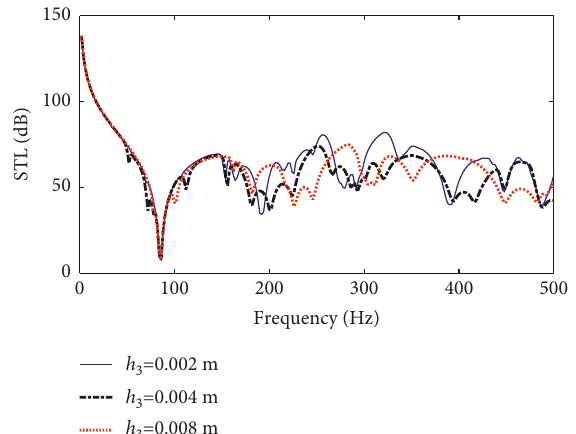
Figure 17: Sound transmission loss of the stiffened double panel- cavity coupled system with different thickness h 3